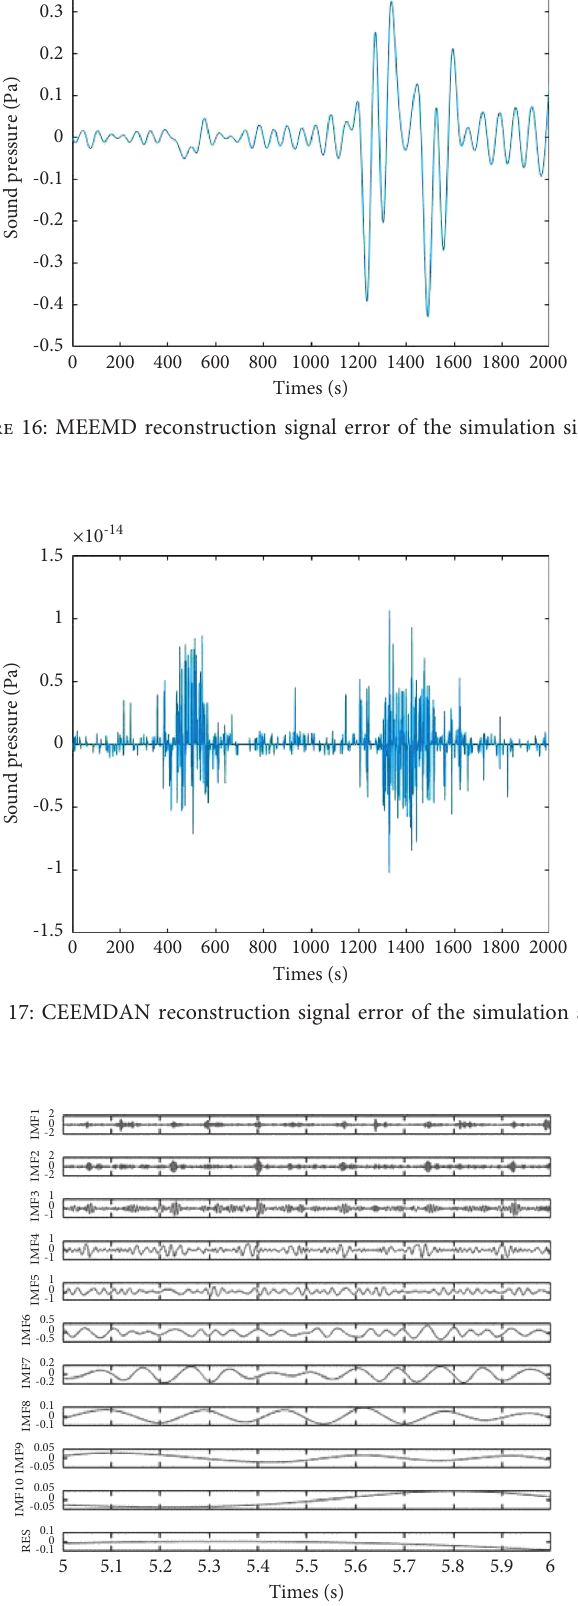
Figure 18: Results of